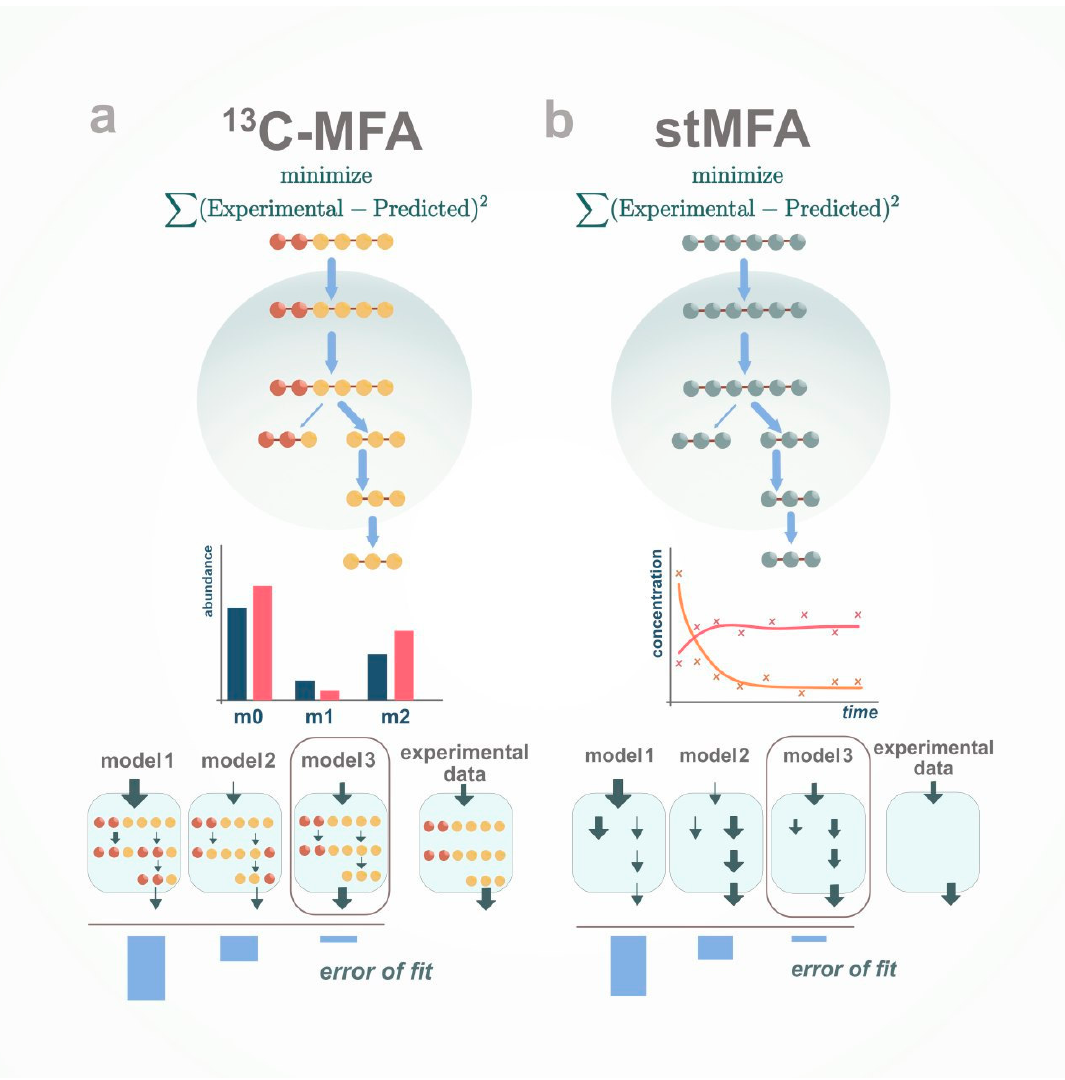
Figure 2. Metabolic flux analysis. MFA is an optimization problem that minimizes the difference between simulated and experimental flux data and labelling pattern data in case 13 C-MFA and solely flux data in case stMFA. ( a ) 13 C-MFA relies on balancing measured and unmeasured rates and patterns of isotopic labelling given the metabolic model; ( b ) stMFA relies solely on balancing measured and unmeasured rates given metabolic model.